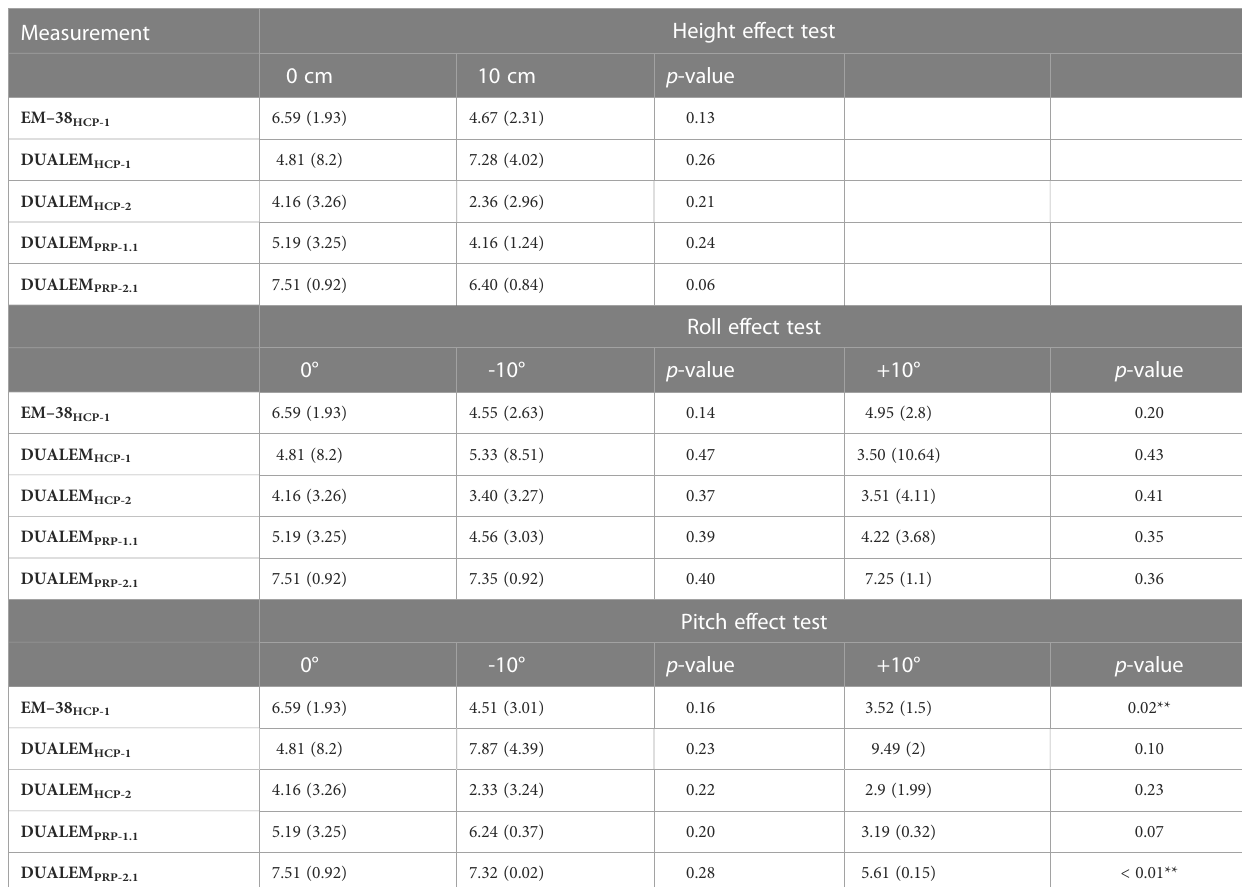
TABLE 6 (The soil EC a (mS/m) measurements for operational tests.